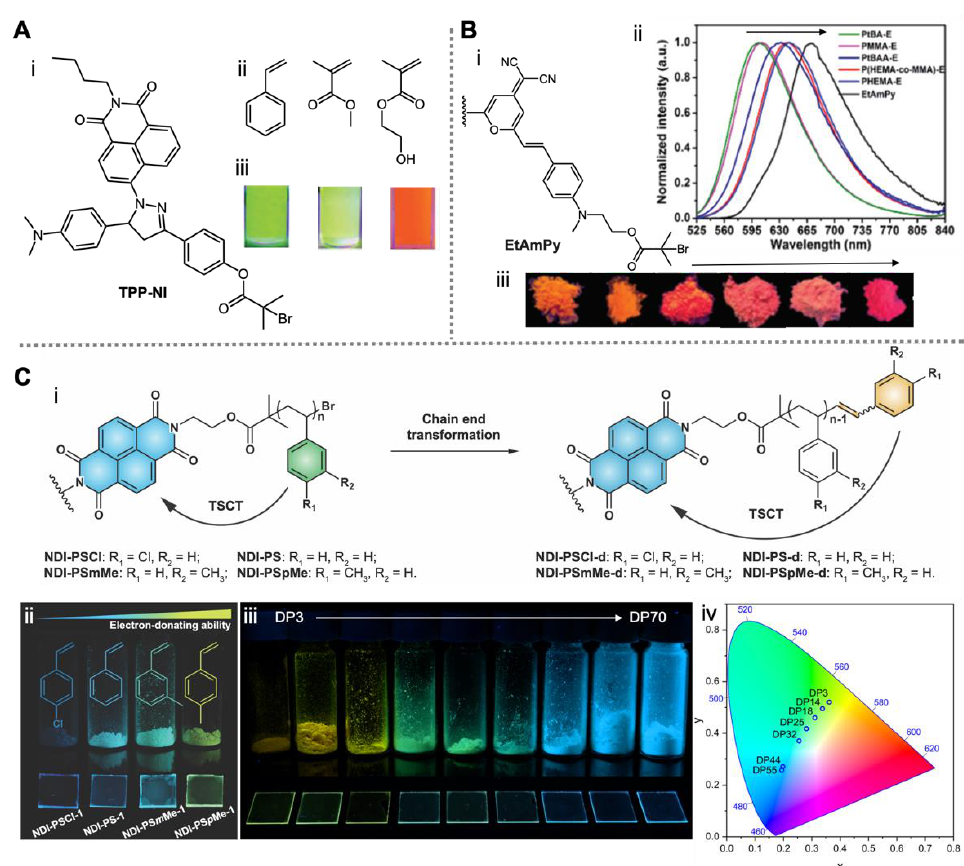
Figure 2. Single-fluorophore AIE polymers prepared by ATRP. ( A ) Structure of a naphthalimide-based AIE initiator (i) and the corresponding monomers (ii), as well as the photographs of the resulting polymers under UV irradiation in their aggregate state (iii). Reproduced with permission from [40], copyright 2012, Royal Society of Chemistry. ( B ) Structure of an ICT initiator (i), the fluorescence spectra of the various resulting polymers in their aggregated state (ii) and the photographs of the polymer powders under UV irradiation (iii). Reproduced with permission from [44], copyright 2018, Royal Society of Chemistry. ( C ) Structure of NDI -based TSCT polymers before and after end group transformation (i), photographs of the polymers using different styrenic monomers (ii) or using styrene with different chain lengths under UV irradiation (iii) and the corresponding CIE coordinates (iv). Reproduced with permission from [47], open access, American Association for the Advancement of Science.